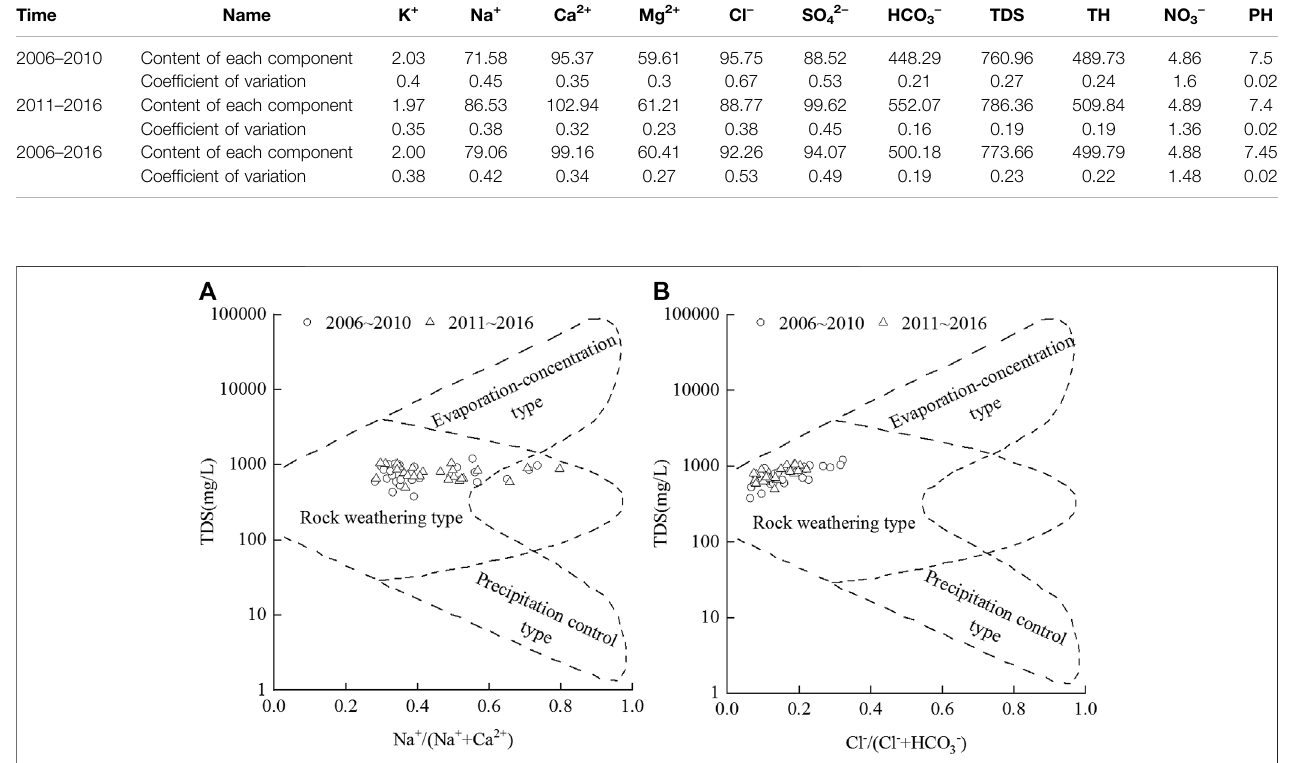
FIGURE 4 | Gibbs diagram for different periods in the study area.